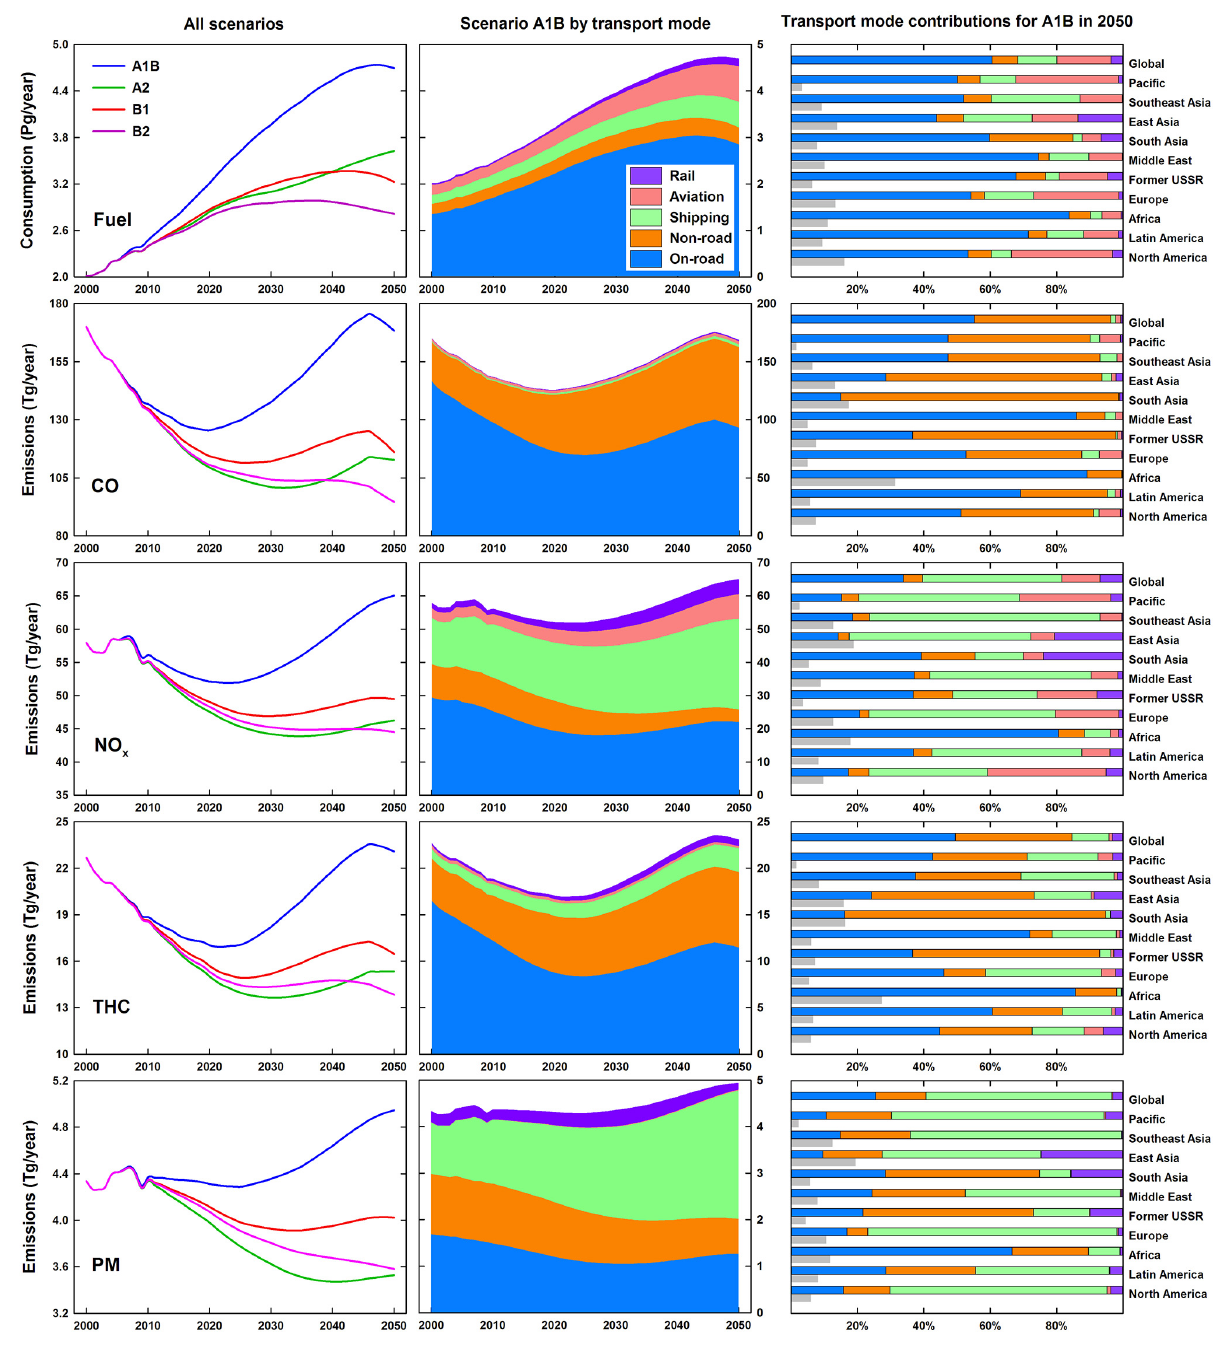
Figure 2. Estimated global fuel consumption and emissions of CO, NO x , THC, and PM from the transportation sector under all scenarios (A1B, A2, B1, and B2) (left) by transport mode under scenario A1B (middle), and by transport mode fractional contribution in different regions under scenario A1B in year 2050 (right). The gray bars in the right panel represent regional contributions to the global